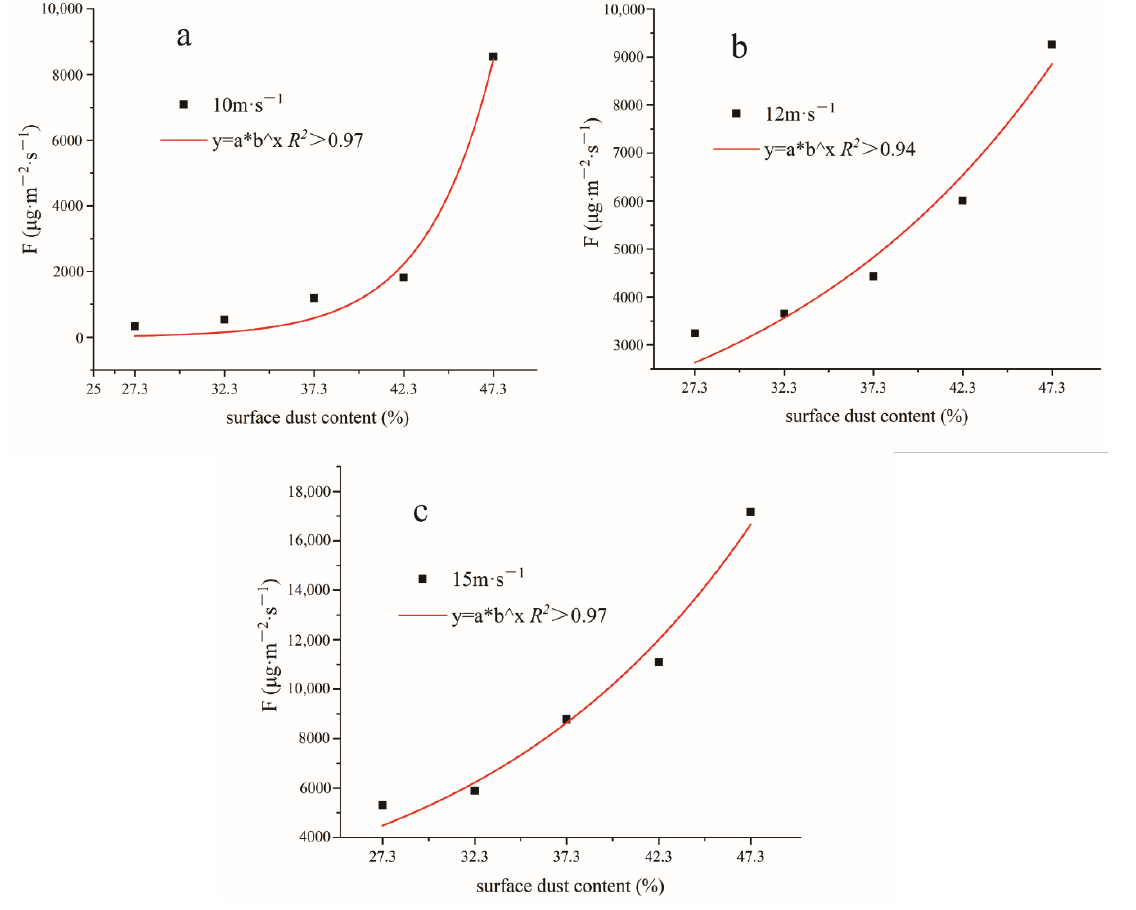
Figure 5. Variation of F with dust contents under different experimental wind velocities. ( a ) U = 10 m · s − 1 , ( b ) U = 12 m · s − 1 , ( c ) U = 15 m · s − 1 . Table 2. Regression coefficients in Equation